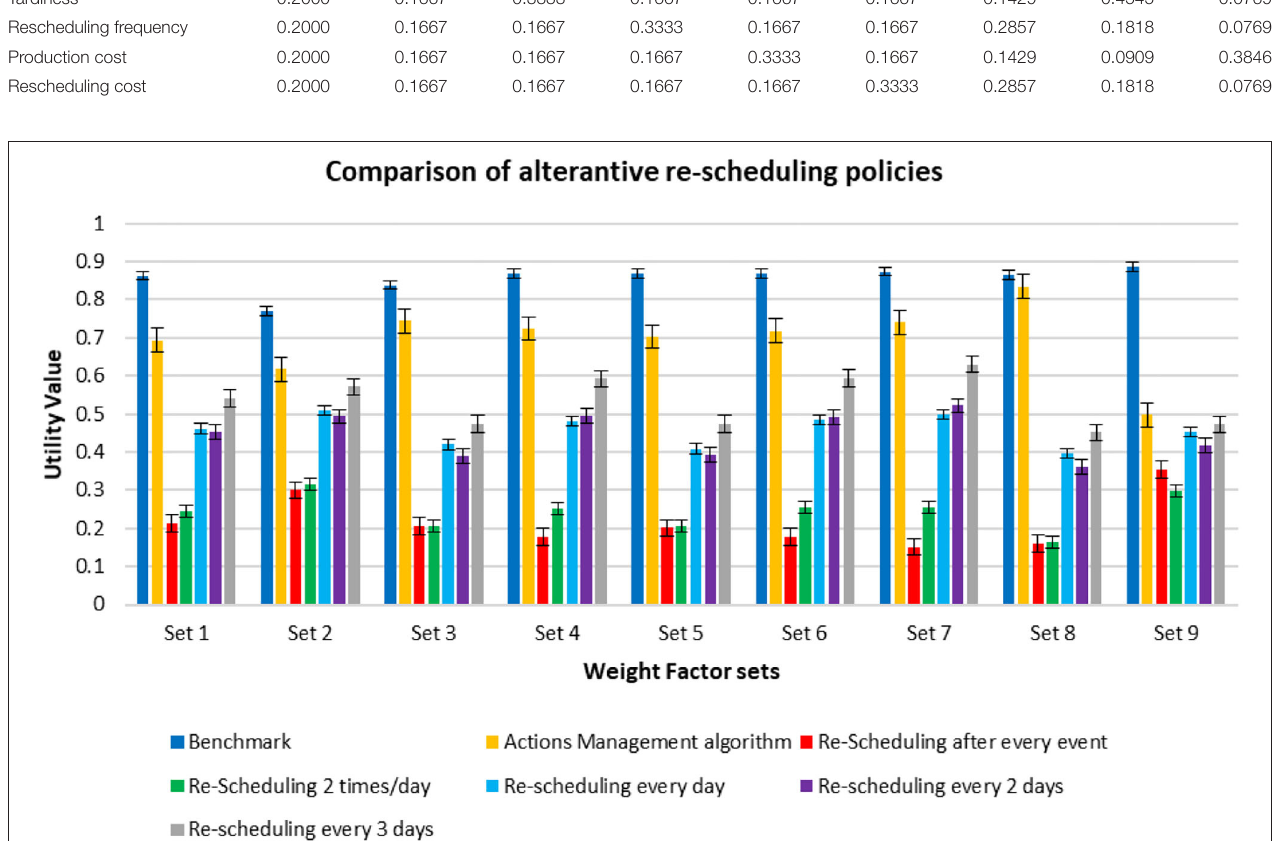
FIGURE 2 | Comparison of alternative re-scheduling policies.